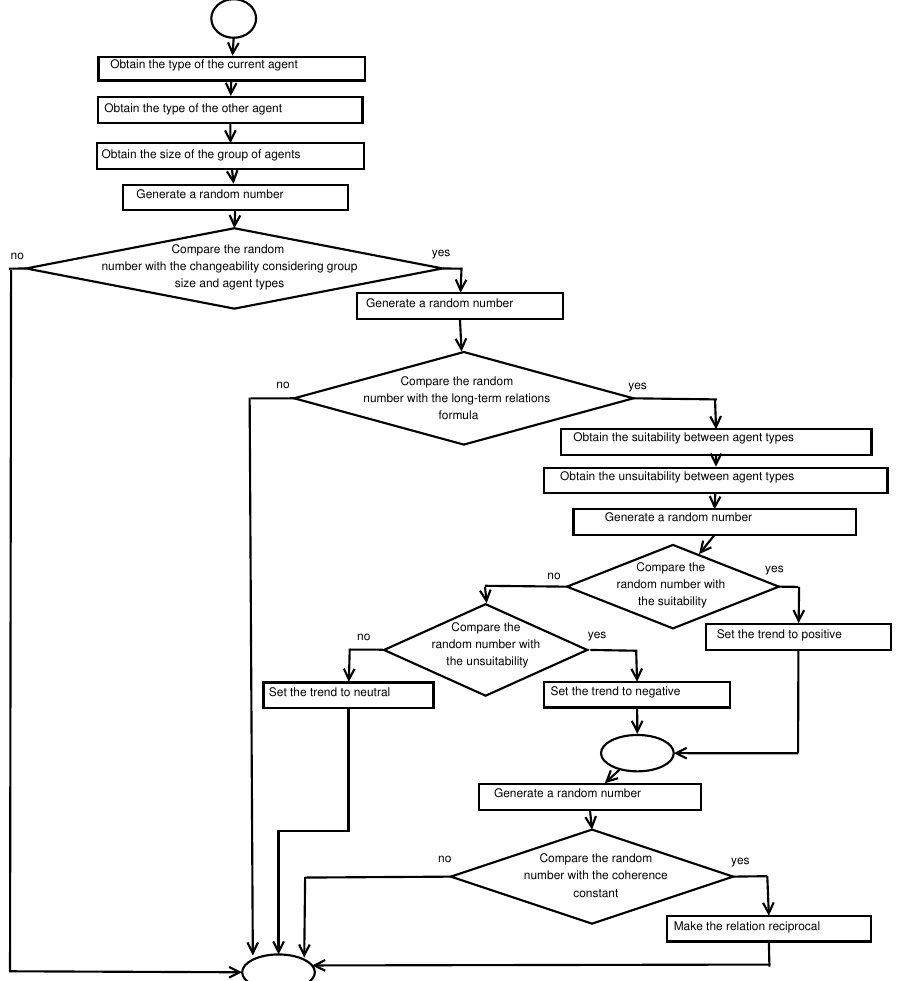
Figure 6. Dataflow diagram for updating the